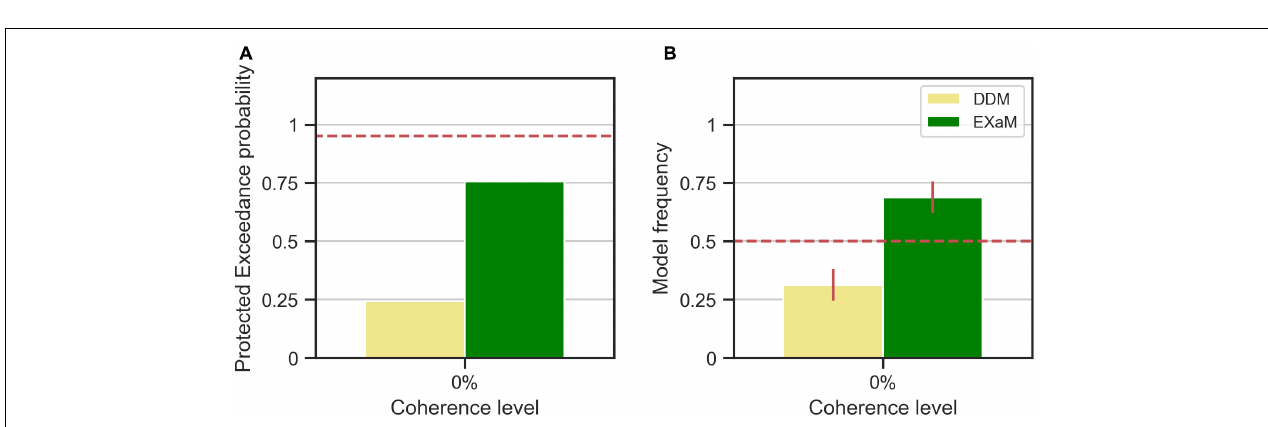
FIGURE 4 | Results of random-effects Bayesian model comparison between DDM and EXaM for 0% coherence across 44 participants, (A) Protected exceedance probability (probability that a model is the best model for all participants). The red dashed line indicates very strong evidence for a model (0.95). (B) Model frequency, i.e., the probability that a randomly selected participant’s behavior is best explained by the specific model. The red dashed line represents chance level and error bars indicate the standard deviation of the estimated model frequencies.